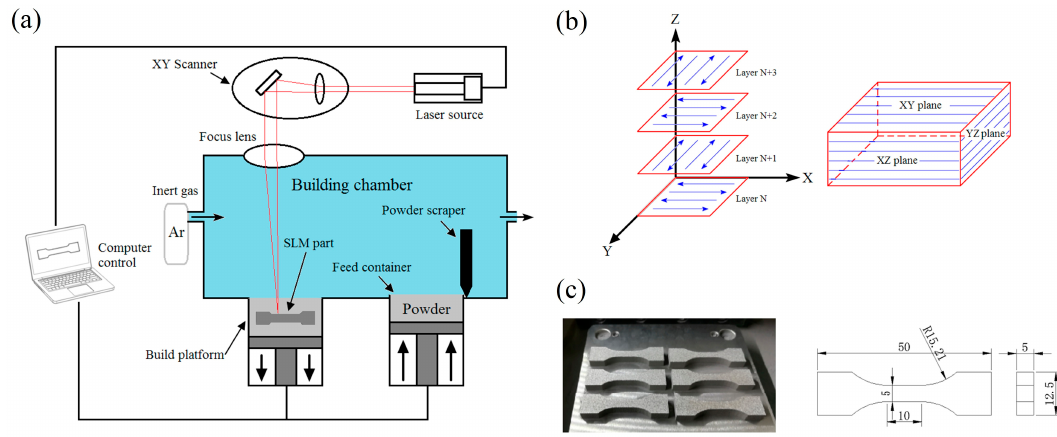
Figure 3. ( a ) Schematic of SLM system, ( b ) scanning strategy and ( c ) SLM-processed tensile specimens.